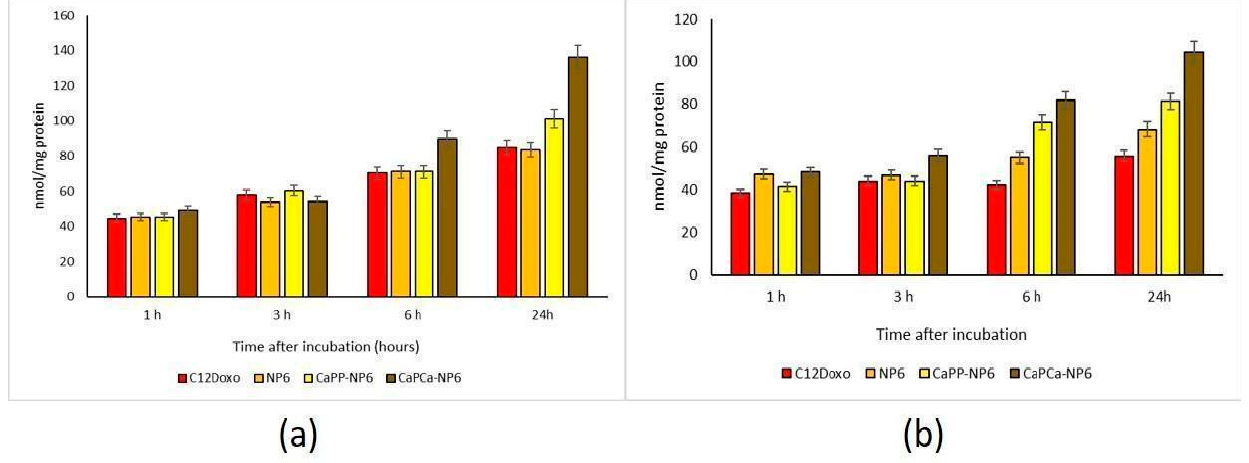
Figure 5. U-2OS ( a ) and U-2OS/DX ( b ) cells were incubated with 5 µg/mL C12 DOXO or with NP6, CaP P -NP6, and CaP Ca -NP6, carrying 5 µg/mL C12DOXO, for 1, 3, 6, and 24 h. Intracellular retention of DOXO was measured spectrofluorimetrically. Results are means + SD ( n = 3). U-2OS, 6 h: p < 0.01 for C12DOXO, NP6, and CaP P -NP6; p < 0.001 for CaP Ca -NP6. U-2OS, 6 h: p < 0.001 for C12DOXO, NP6, CaP P -NP6, and CaP Ca -NP6 (all parameters compared to 1 h). CaP P -NP6 vs. C12DOXO, NP6, and CaP P -NP6: p < 0.01 at 6 h; p < 0.001 at 24 h. U-2OS/DX, 6 h: p < 0.01 for CaP P -NP6; p < 0.001 for CaP Ca -NP6. U-2OS/DX, 24 h: p < 0.05 for NP6, p < 0.01 for CaP P -NP6; p < 0.001 for CaP Ca -NP6 (all parameters compared to 1 h). For NP6 vs. C12DOXO: p < 0.05 at 6 and 24 h. CaP P -NP6 and CaP P -NP6 vs. C12DOXO and NP6: p < 0.001 at 6 h and 24 h.